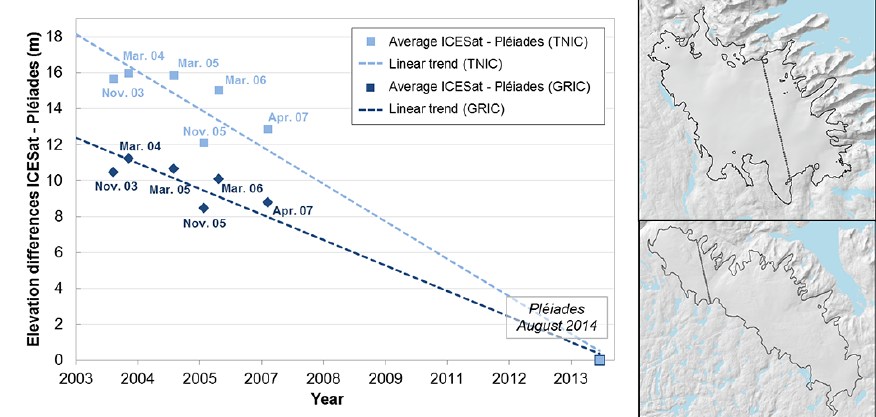
Figure 7. Recent elevation differences on GRIC and TNIC measured between the Pléiades DEMs (2014) and ICESat altimetric points (2003 to 2007). Only the complete ICESat tracks available for both ice caps were used. The trend lines indicate the mean rate of elevation changes along these two ICESat reference tracks and are ∼− 1.1ma − 1 for GRIC and ∼− 1.6ma − 1 for TNIC. Transects location for each ice cap is shown on the inset maps (top for GRIC and bottom for TNIC).